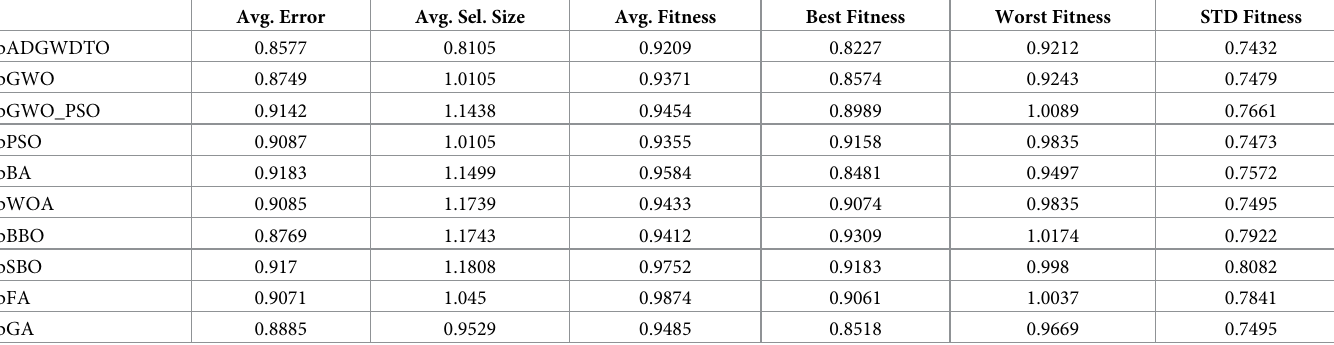
Table 6. Performance of proposed algorithm compared to state-of-the-art algorithms for feature selection.